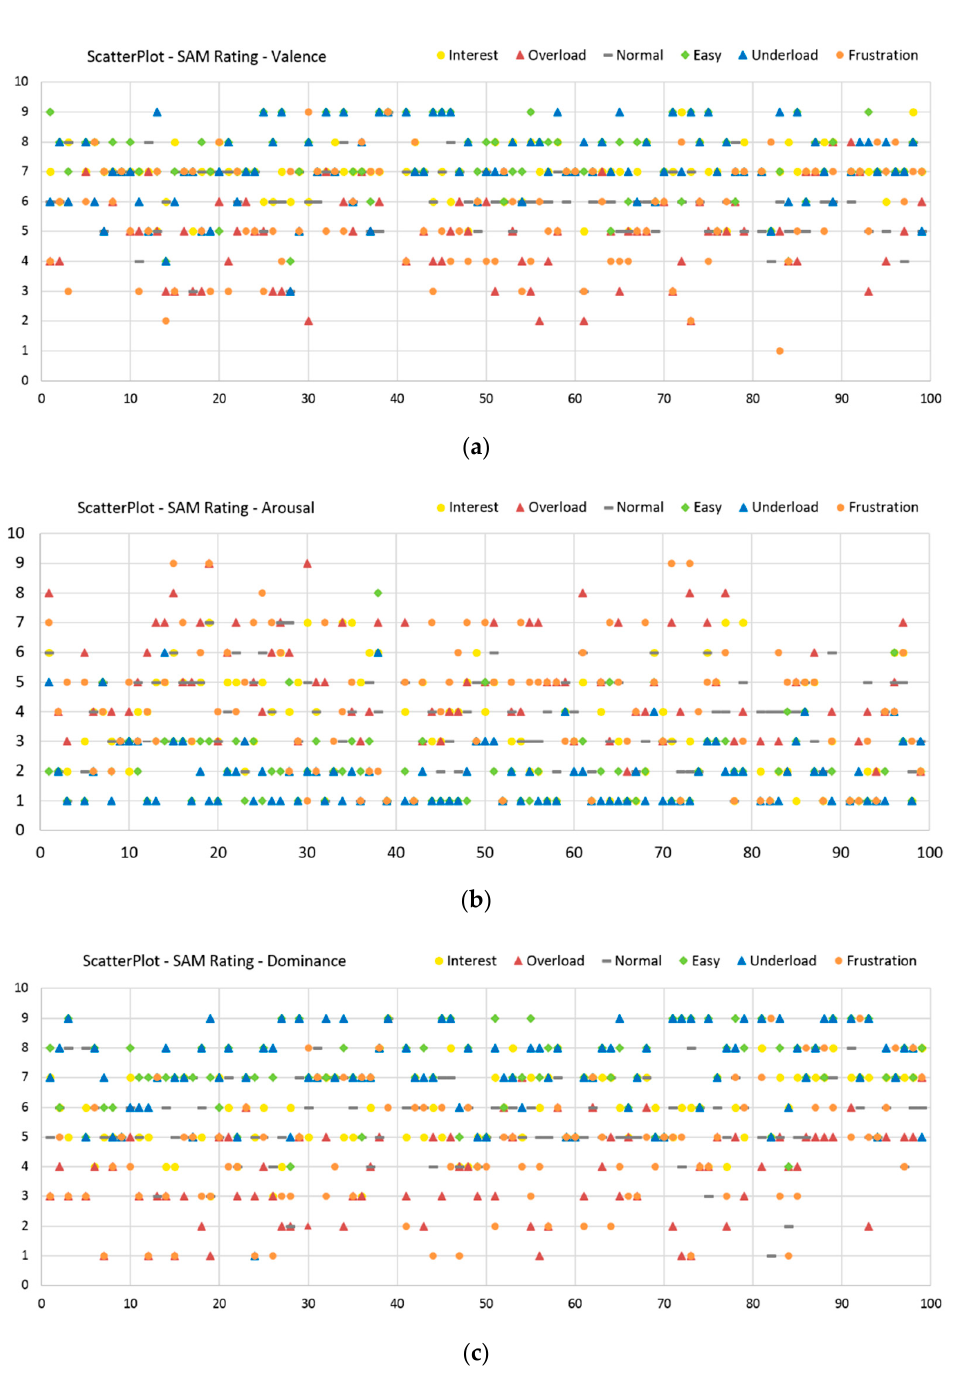
Figure A1. ( a ) Ratings distribution of the Valence dimension for all the measurements. ( b ) Ratings distribution of the Arousal dimension for all the measurements. ( c ) Ratings distribution of the Dominance dimension for all the measurements.